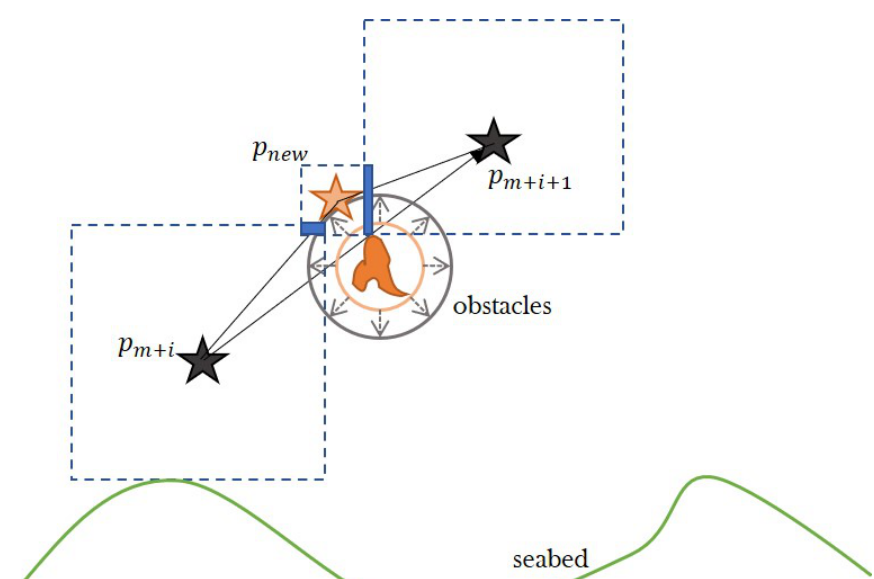
Figure 11. Two-dimensional corridors of p new and p (cid:48) corridor of p new intersects with the p (cid:48) part of the target spots